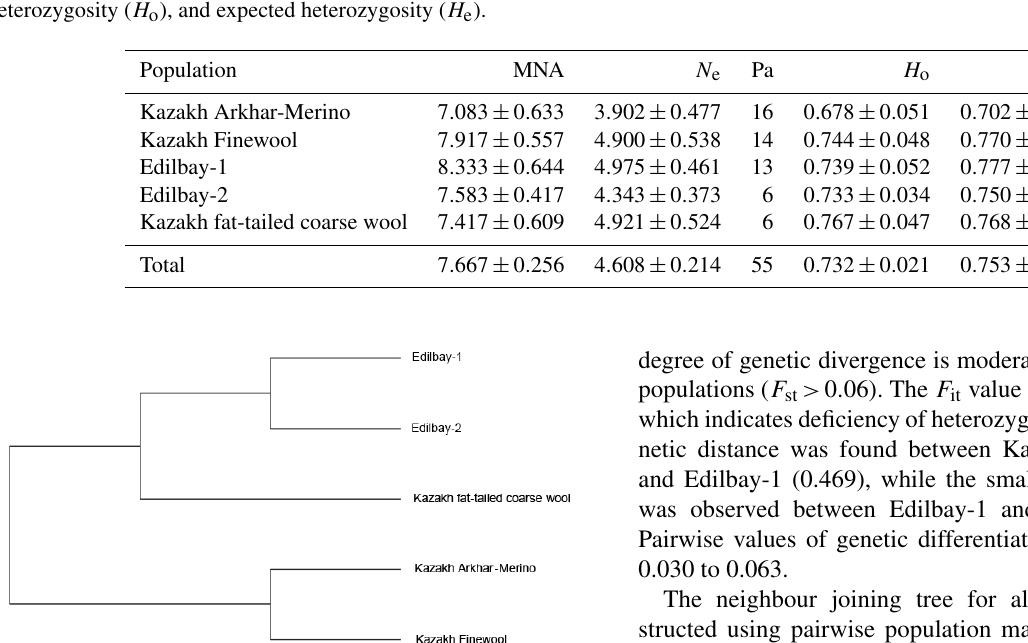
Table 2. Genetic diversity within the five sheep populations. Mean number of alleles (MNA), effective number of alleles ( N e ), observed heterozygosity ( H o ), and expected heterozygosity ( H e ).